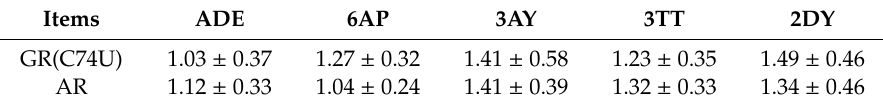
Figure 4. ( A ) Comparison of the H-bonds formed between ligands (6AP, 3AY, and 3TT) and nucleotides U51 and U74 in the GR(C74U) complexes; the representative structures are from the MD simulation. The distances of H-bonds are labeled in black, red, and green colors in 3AY, 3TT, and ADE, respectively. ( B ) The distances between the mass centers of 3AY / 3TT and the two aromatic rings of A21 and U22 are labeled. The representative structures of ligands and nucleotides are from MD simulations; they are shown in stick-and-ball representation for the 3AY complex and in stick representation for the 3TT complex. Table 2. The average root-mean-square deviations (RMSDs) of the key six nucleotides